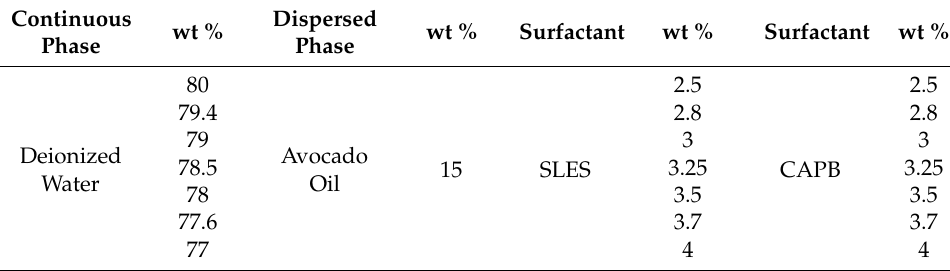
Table 2. Avocado Oil Emulsion